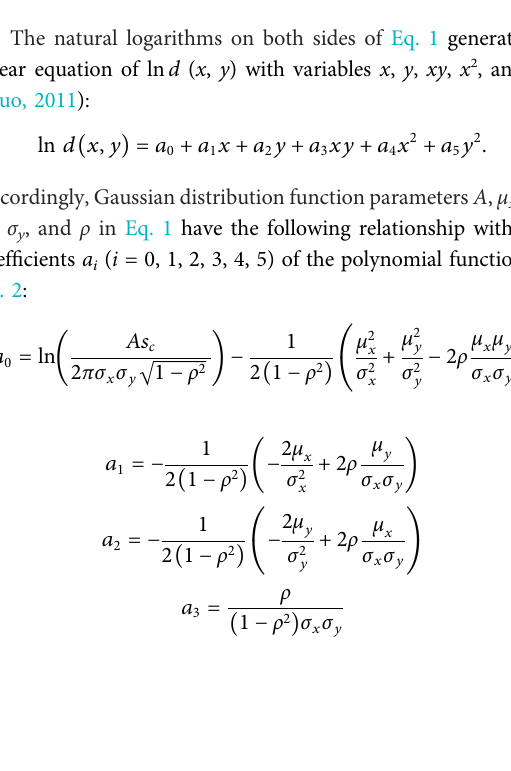
Frontiers in Robotics and